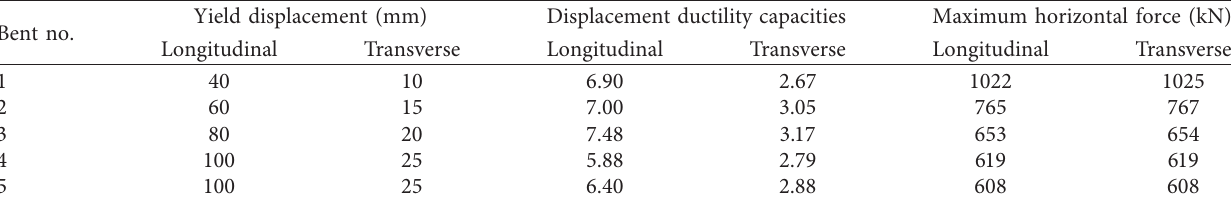
Table 2: Pushover results of the